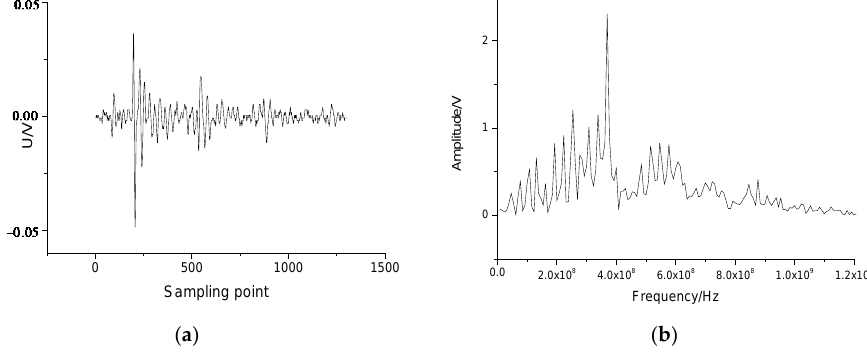
Figure 15. Time-frequency signals received by Antenna sensor in air environment without transformer tank: ( a ) Signal in time domain; ( b ) Signal in frequency domain.